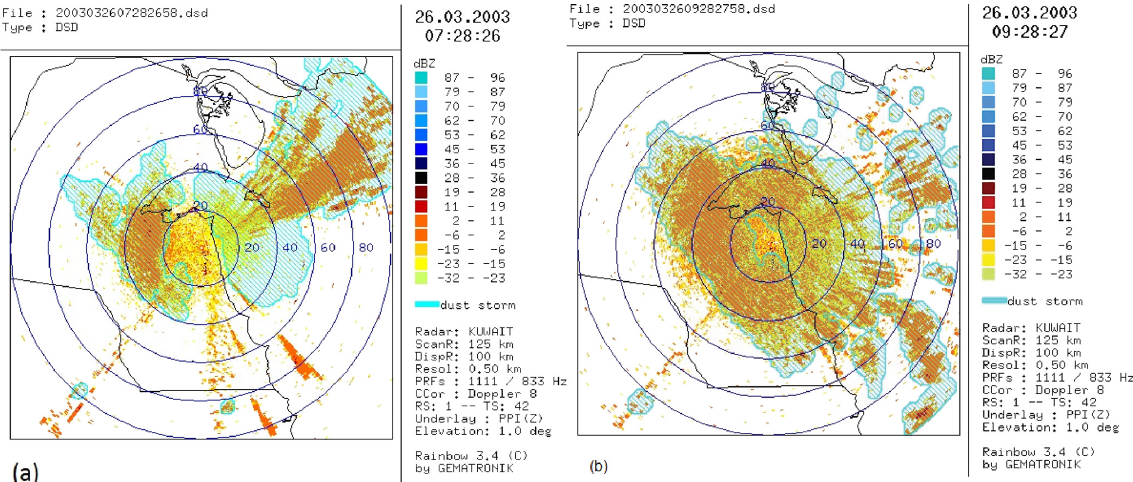
Fig. 6. The radar display of reflectivity Z at the beginning of the dust storm, approximately 07:30LT (a) , and at a later stage, approximately 09:30LT (b) .